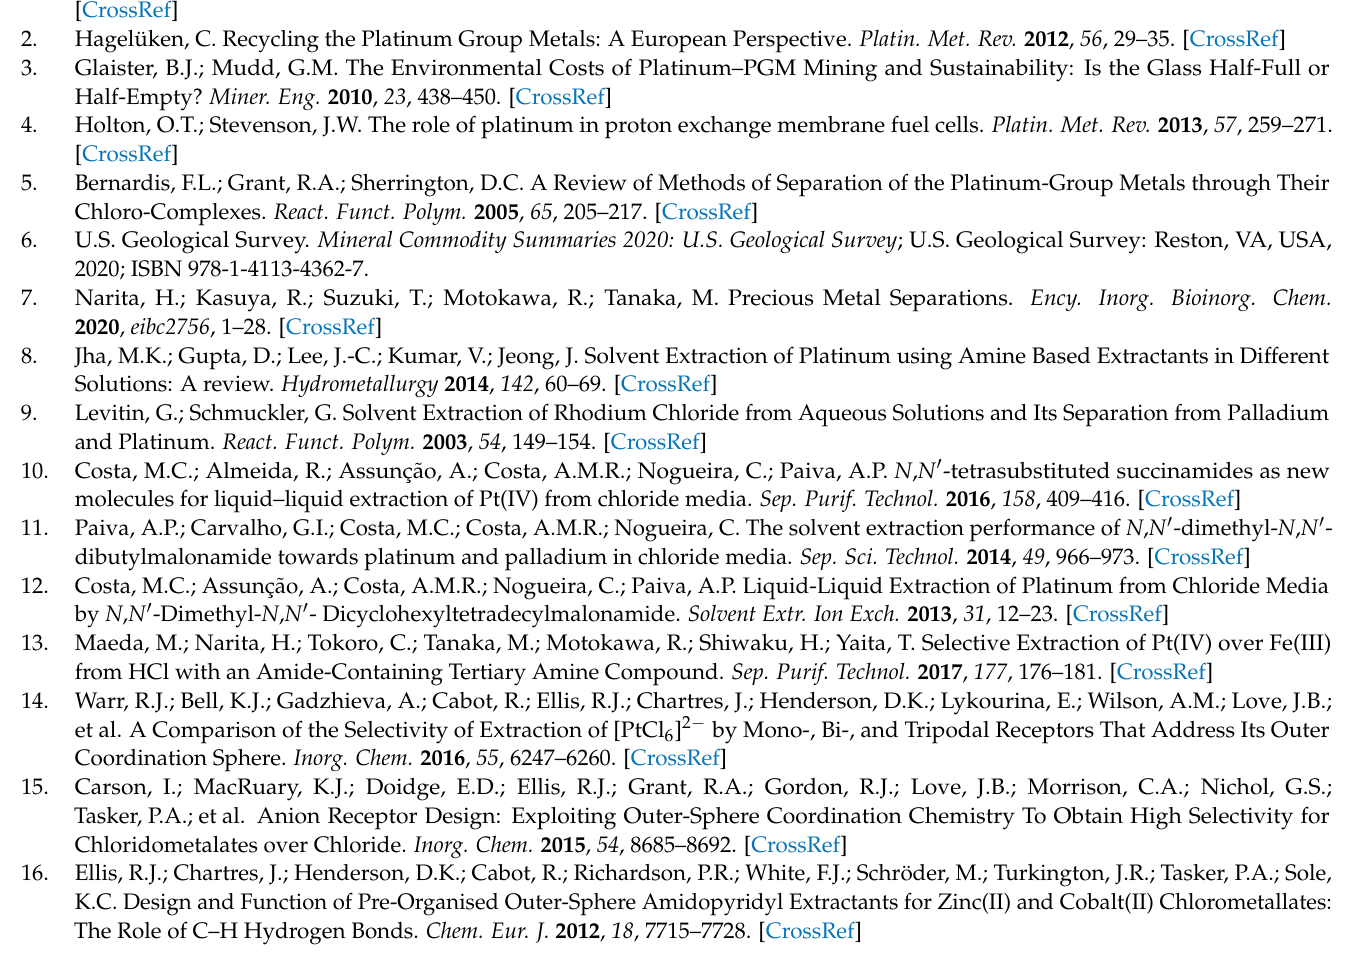
Figure S4: IR spectra of N -(2-ethylhexyl)octanamide (MonoOA), Figure S5: 1 H NMR spectra of (a) N , N